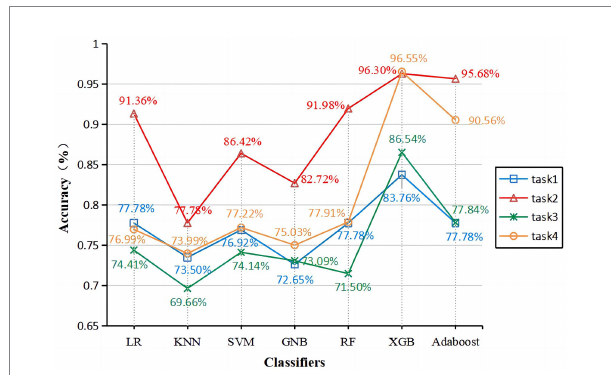
FIGURE 3 Accuracy of each classifier on four tasks. Task1 (blue line), Task2 (red line), Task3 (green line), and Task4 (orange